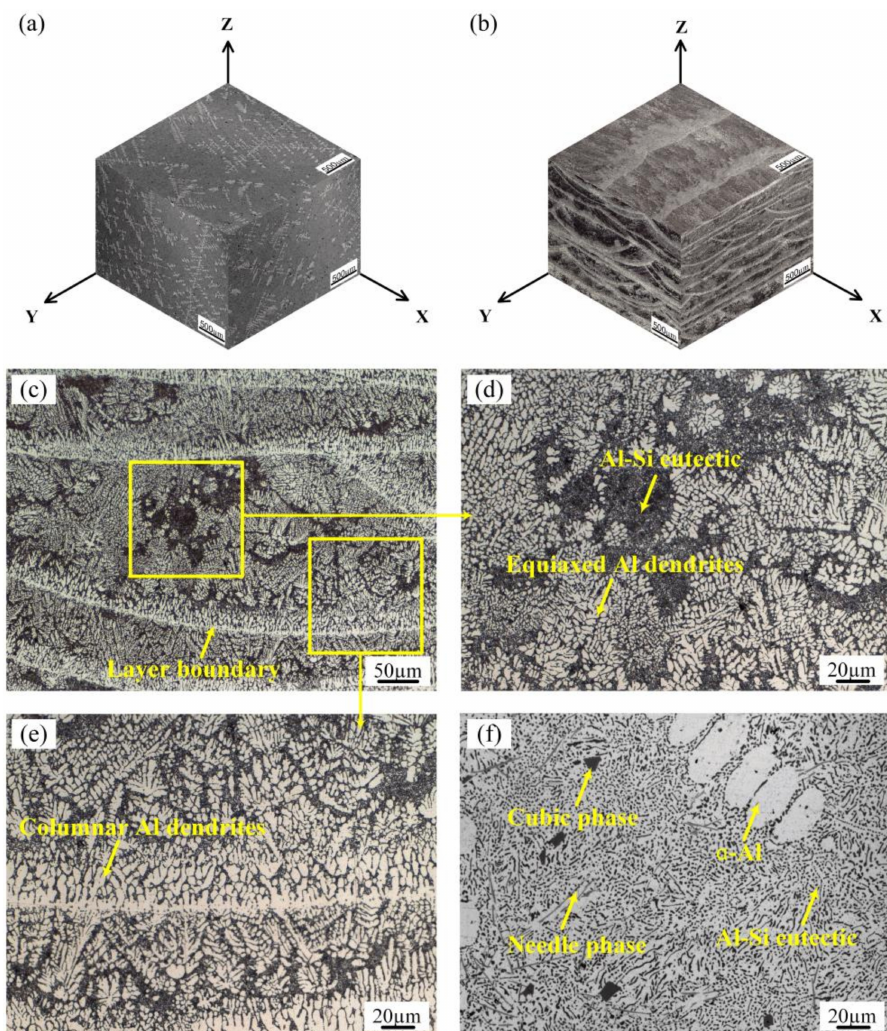
Figure 4. OM micrographs of the Al 4047samples: ( a ) 3D microstructure built by casting; ( b ) 3D microstructure built by the ultrasonic-assisted laser metal deposition UALMD; ( c ) amplifying the metallographic structure of the XZ section in 4b; ( d ) the equiaxed dendrite near the top of the layer; ( e ) the columnar dendrite at the bottom of the layer; and ( f ) amplification of the metallographic structure in